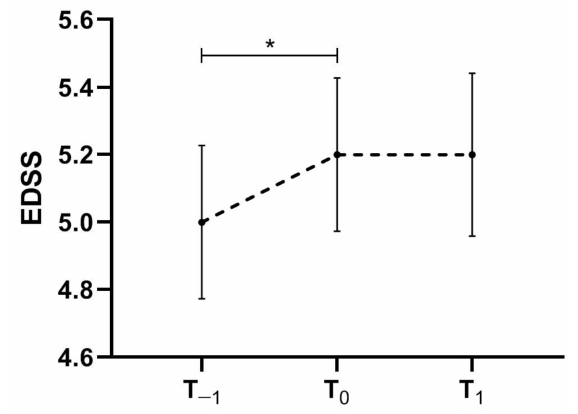
Figure 1. EDSS trajectory between T − 1 , T 0 and T 1 for the whole multiple sclerosis sample included in the effectiveness analysis. * p < 0.05 at multivariable mixed models including time-points as factor of interest, EDSS as the dependent variable, age, gender and centre as covariates and subject ID as a random factor. Dash line represents EDSS